Question: Write a caption explaining this figure to a reader.
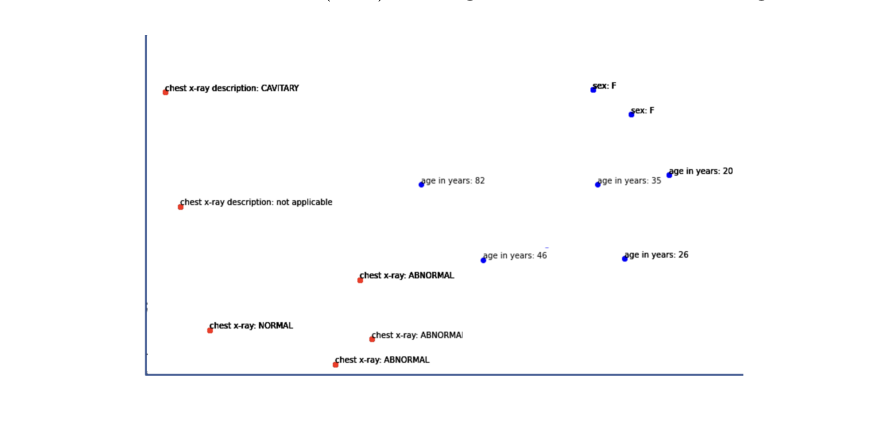
Answer: Clustering of Personal vs Diagnostic Entities - Two dimensional projection of embedding vectors of metadata fields and values. Red terms correctly clustered diagnostic metadata and purple terms clustered patient metadata. The axes are a projection of large vector dimensions on to a 2D space and hence are unlabelled.